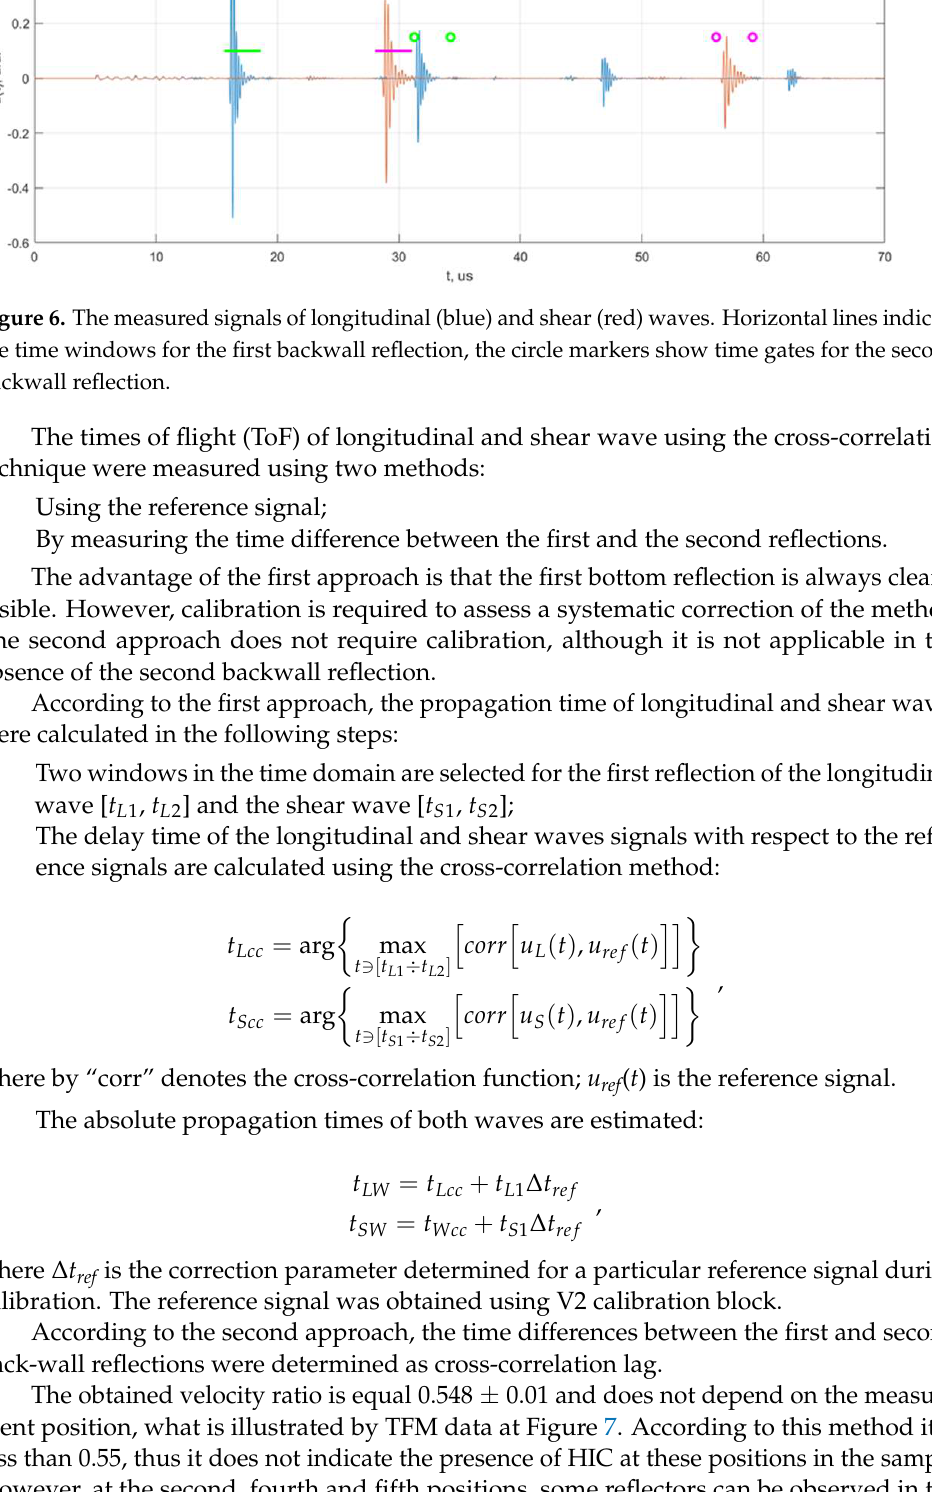
10 of 24 Table 4. Coordinates of acquisition points for AVR measurements. Measurement Point Reference